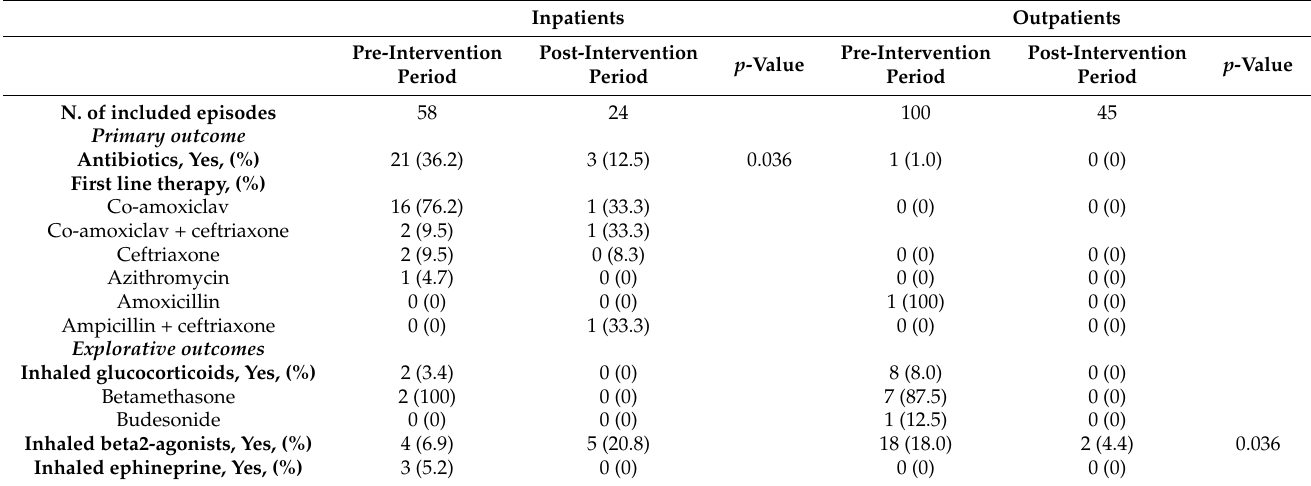
Table 2. Bronchiolitis treatment for inpatients and outpatients with significant p values.